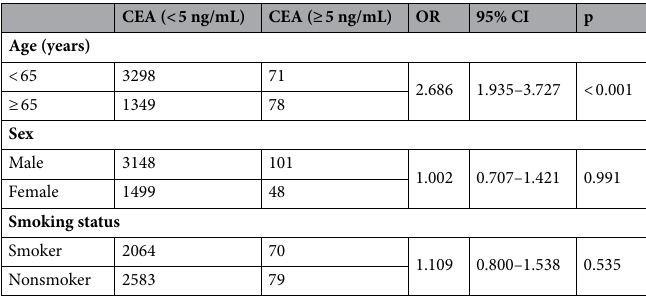
Table 2. Risk factors of CEA abnormalities.